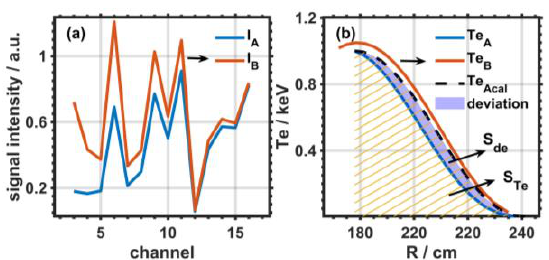
Fig. 3. Calibration of multi-channel ECE radiometry by magnetic field difference method. (a) Measured positions at B t00 = 1.5 T and B t01 = 1.532 T, (b) The position deviation between adjacent channels ( δR m ) as B t01 increases from 1.5 T to 1.6 T.